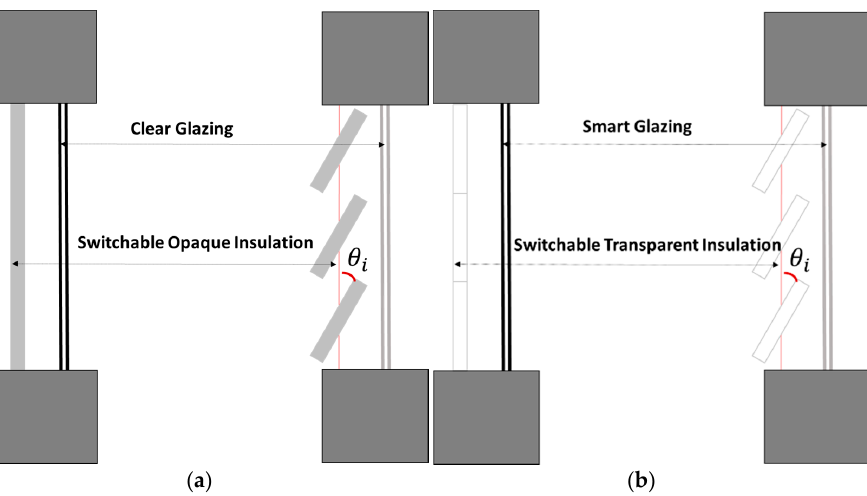
Figure 1. Two configurations for switchable insulation system applied to windows using ( a ) opaque insulation applied to a conventional glazed window, ( b ) a transparent insulation system (i.e., venetian blinds made up of monolithic silica aerogels) applied to a smart glazed